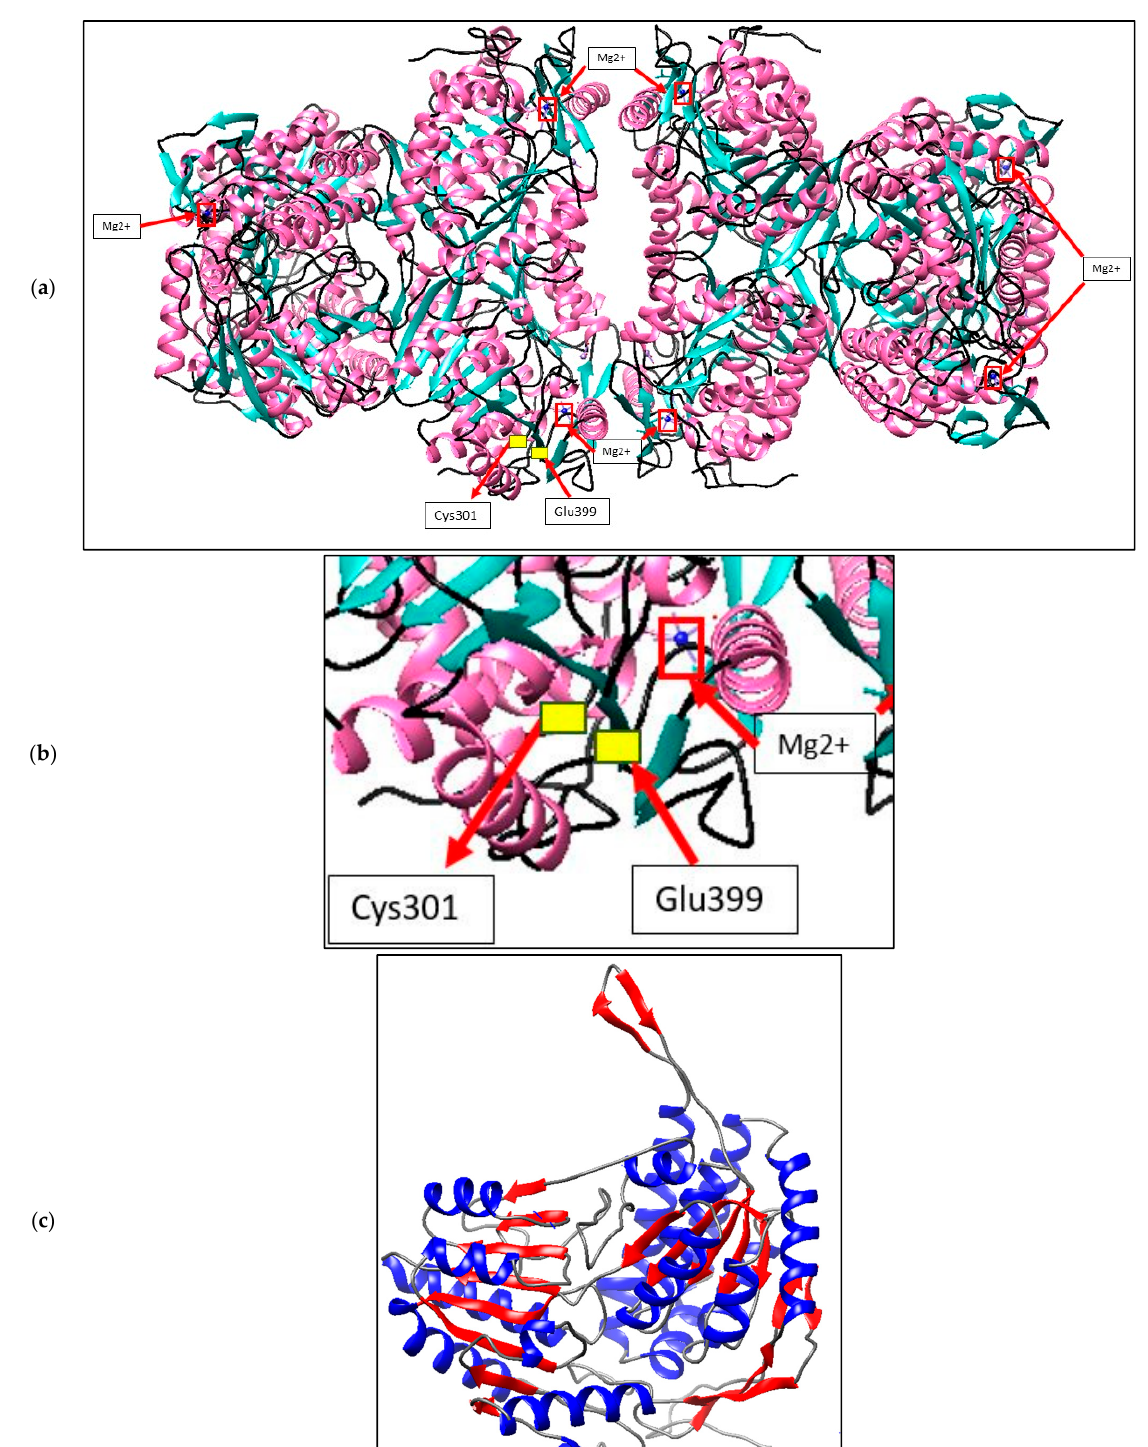
Figure 3. Structure prediction of A. geothermalis ALDH using YASARA software. ( a ) The predicted A. geothermalis ALDH exists as a tetramer composed of four monomers of the subunits. The red boxes represent the metal ions, Mg 2+ . The yellow boxes showed the active site of this A. geothermalis ALDH which are Cys301 and Glu399. ( b ) Active site and metal binding site of A. geothermalis ALDH ( c ) the monomer of the predicted A. geothermalis ALDH. The β -sheets coloured with red and the α -helix coloured with